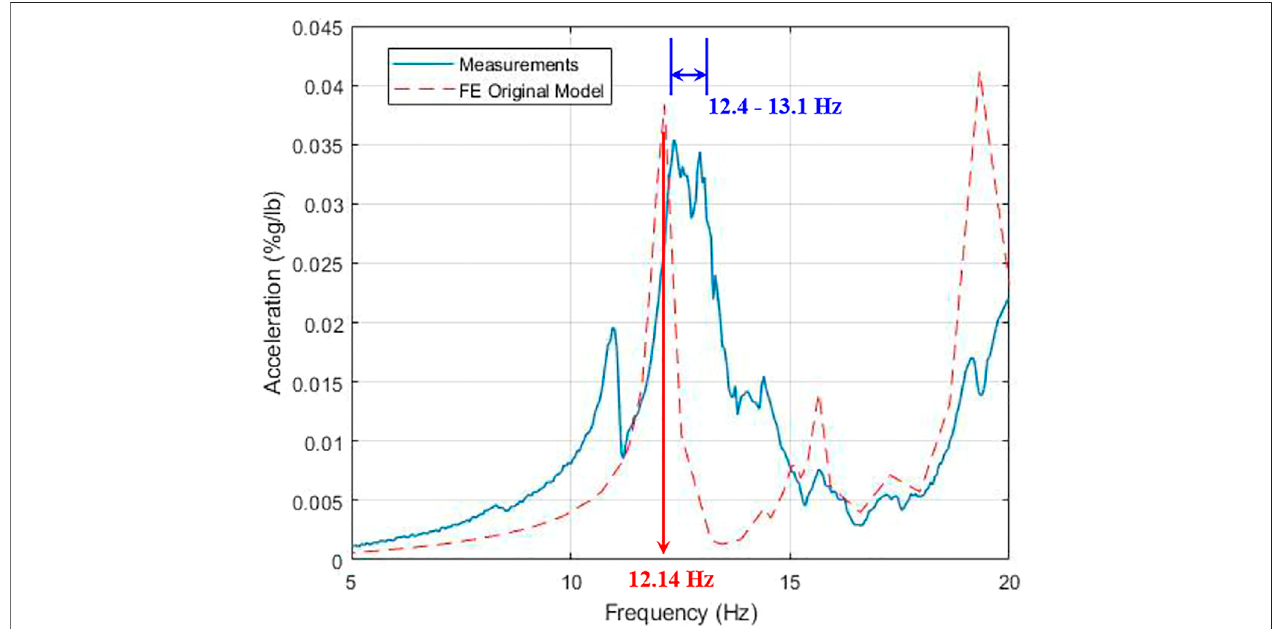
FIGURE 13 | Comparison between the measured FRF and the FE model predicted FRF after the installation of non-structural elements.